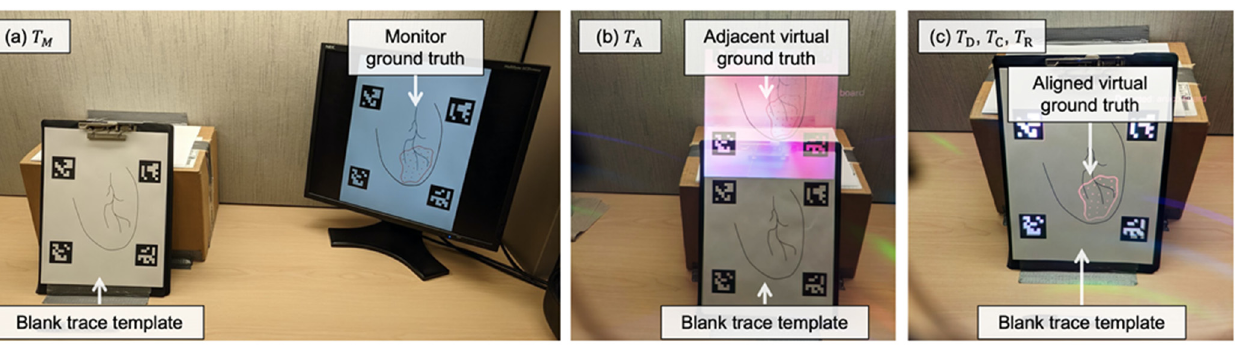
Figure 3. The display paradigms used in this study. ( a ) The monitor-guided condition ( T M ) where the ground truth contour and point locations were displayed (with correct scaling) on a monitor adjacent to the user. ( b ) The HoloLens 2 guided condition ( T A ), recorded through the HoloLens 2 display, with virtual content shown adjacent to the trace template and with the correct scale. ( c )